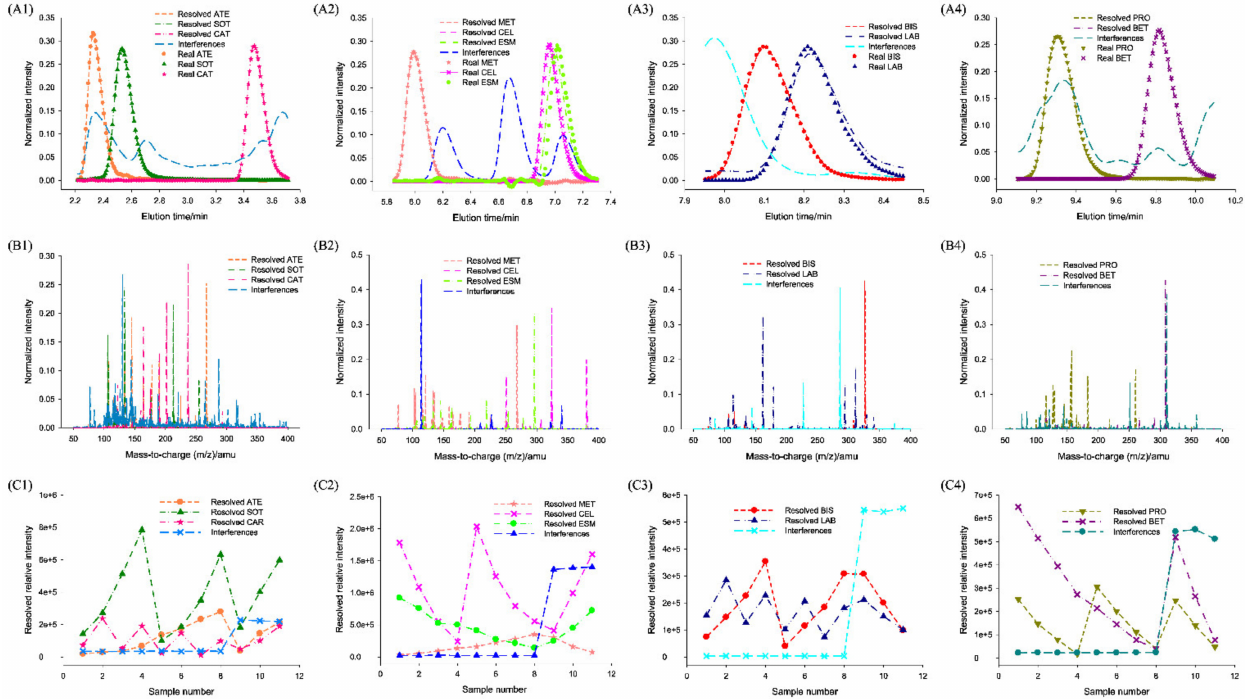
Figure 5. ( A1 – A4 ) ATLD resolved normalized chromatograms, ( B1 – B4 ) normalized mass spectra, and ( C1 – C4 ) relative concentration profiles and ( A1 – A4 ) their corresponding real normalized chromatograms for 10 b-blockers in human urine samples. Reproduced with permission from Gu et al. [150], Analytica Chimica Acta; published by Elsevier, 2014.